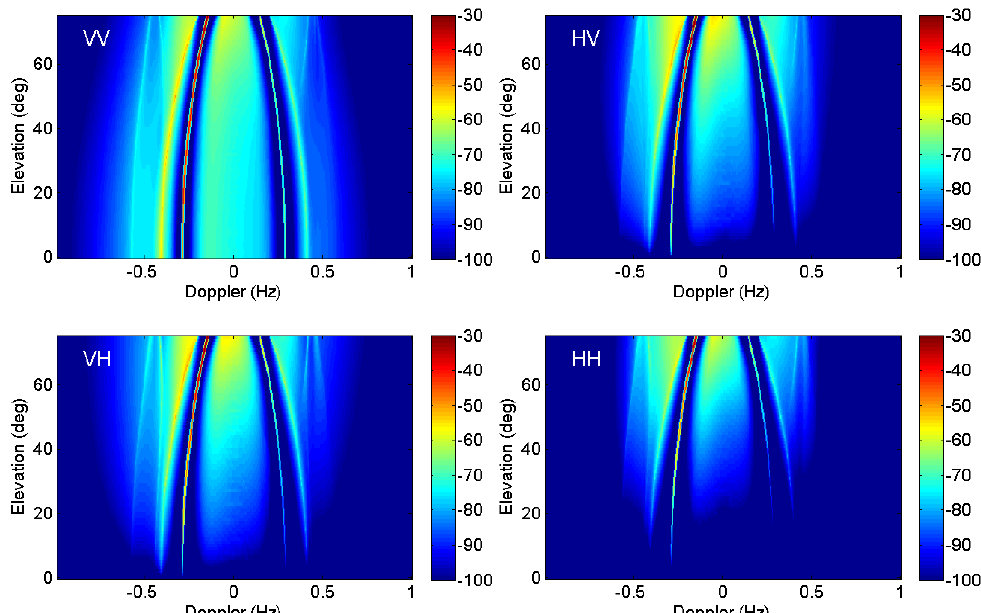
Figure 13. Magnitudes of the elements of the power scattering matrix for similar parameters to those used in Figure 10, except that now the scattering geometry is bistatic, with an azimuthal separation of 60°. The Bragg lines no longer vanish for the cross-polarised elements. As before, colour bars measure power spectral density in dB/Hz. While it is important to understand the dependence of the Doppler spectra on the scattering geometry, it is often sufficient, and sometimes easier, to understand from a vis- ual presentation how the spectrum form changes with elevation. To this end, we subtract the spectrum at zero elevation from the other spectra and plot this difference. Figure 14 is a tableau showing the elevation-Doppler spectra (VV element) in the left column and the difference spectra on the right. The five rows correspond to radar frequencies of 5, 10, 15, 20, and 25 MHz. One avenue for exploiting this property opens when both single-hop and two-hop modes illuminate the target area.